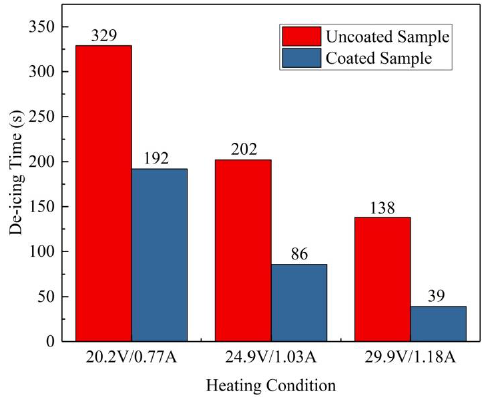
Figure 5. Deicing time under different heating conditions.